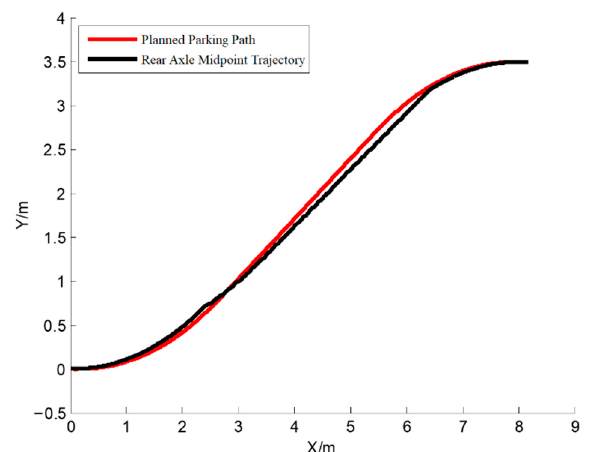
Figure 22. Rear Axle Midpoint Trajectory.